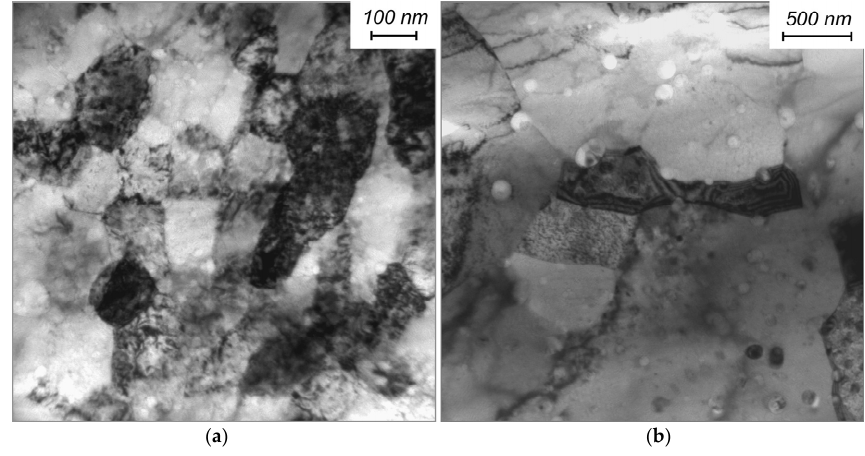
Figure 6. Nano ‐ structured FeMo powders after SPS sintering at 840 °C ( a ) and 855 °C ( b ).